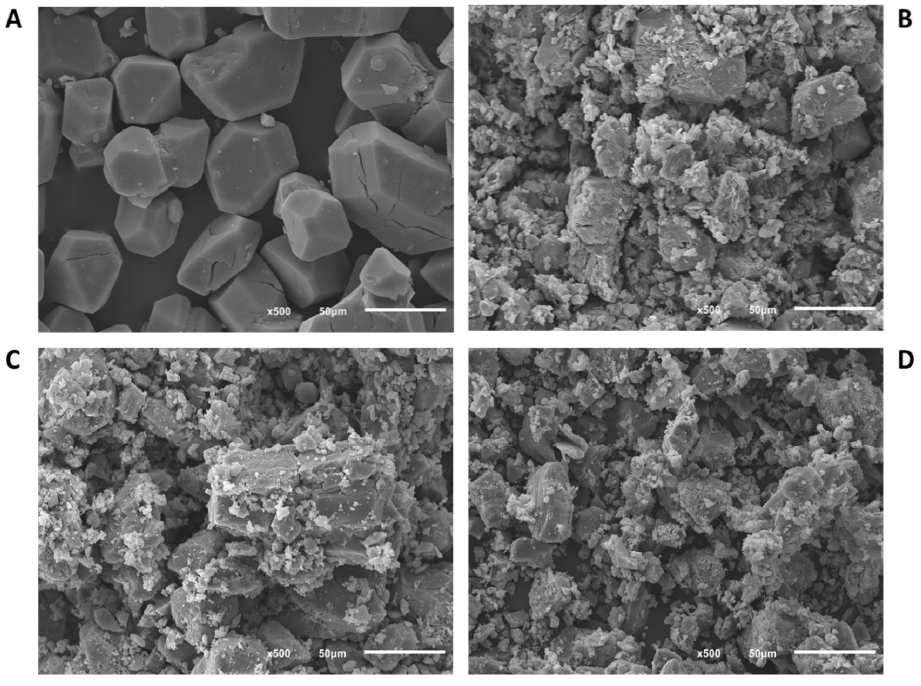
Figure 1. Scanning electron microscope (SEM) images of Basolite C300 (zoom in 50 µm) (( A ): original, ( B ): 55.9 MPa, ( C ): 111.8 MPa, ( D ): 186.3 MPa).